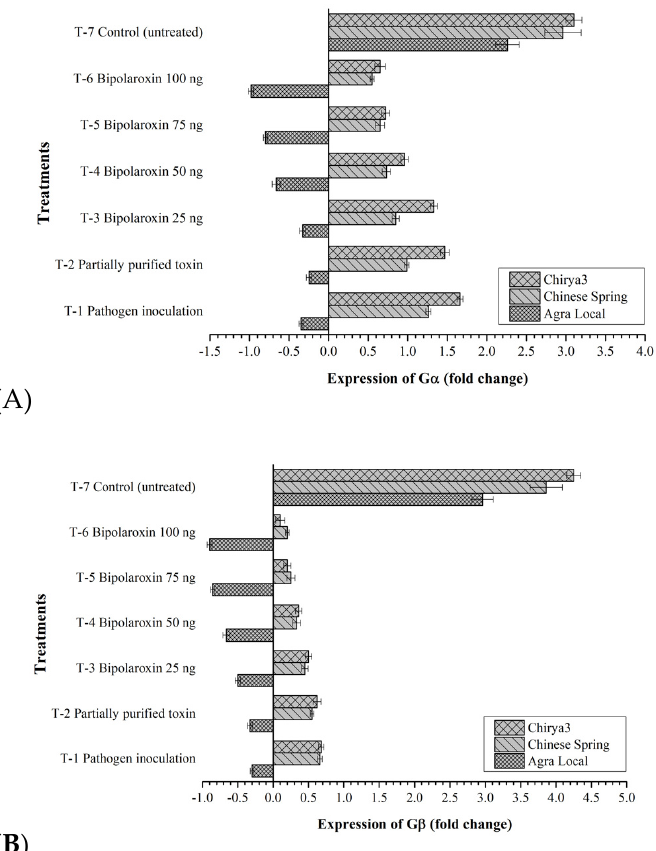
Figure 10. Expression profile of G α ( A ) and G β ( B ) in susceptible line, Agra Local and resistant lines, Chinese Spring, and Chirya3 under pathogen inoculation and infiltration of partially purified toxin obtained from B. sorokiniana as well as chemically synthesized Bipolaroxin at 7 days of inocula- tion/treatments under glasshouse conditions. Data are mean ( n = 3) and vertical lines represent the Standard Deviation (Mean ±